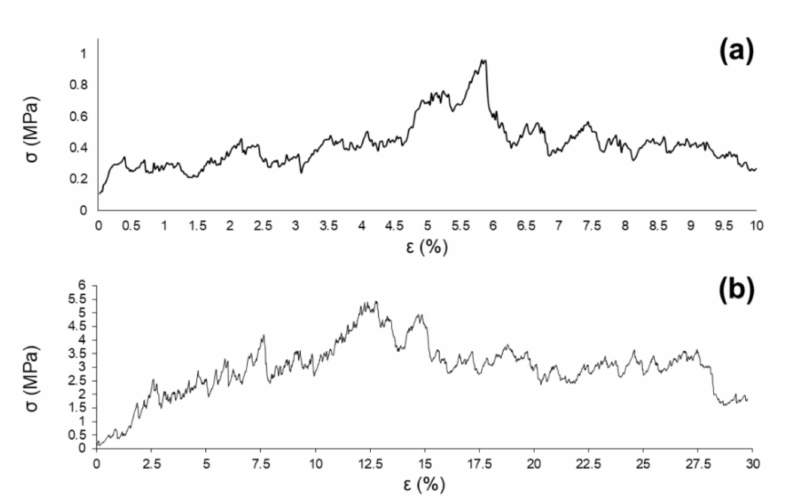
Figure 4. Stress–strain ( σ - ε ) curve of dolomite-foamed D-800 ( a ) and D-850 sca ff olds ( b ).